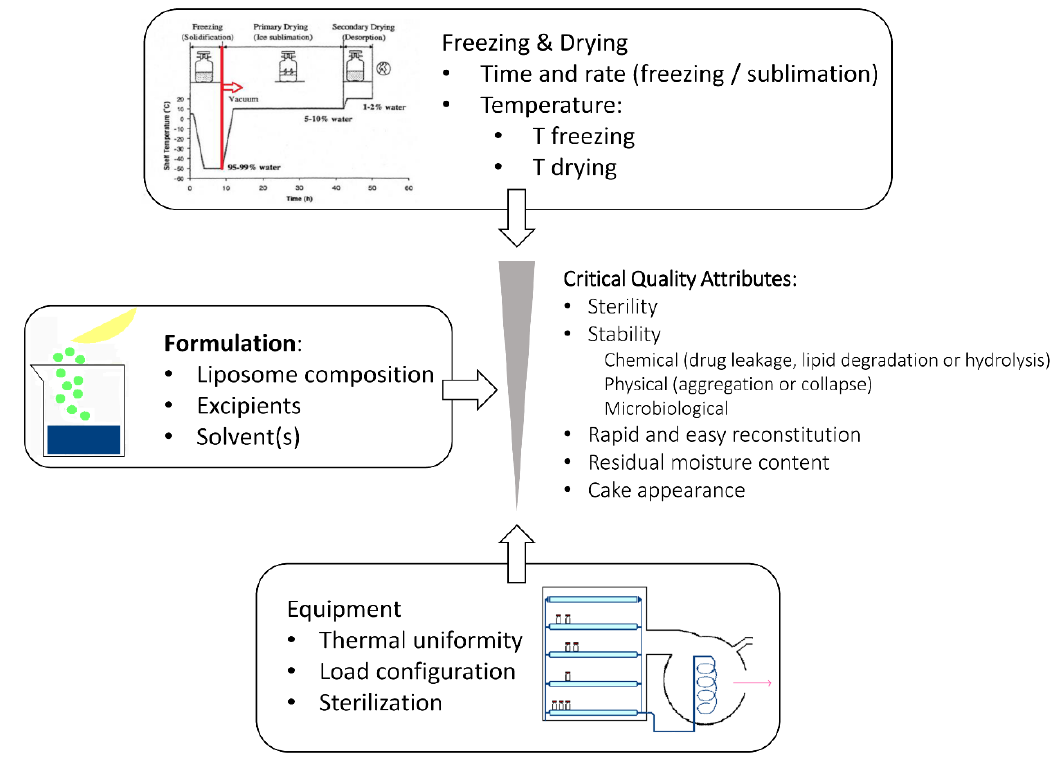
Figure 7. Schematic representation of the factors influencing the critical quality attributes of freeze- dried liposomes. freeze-dried